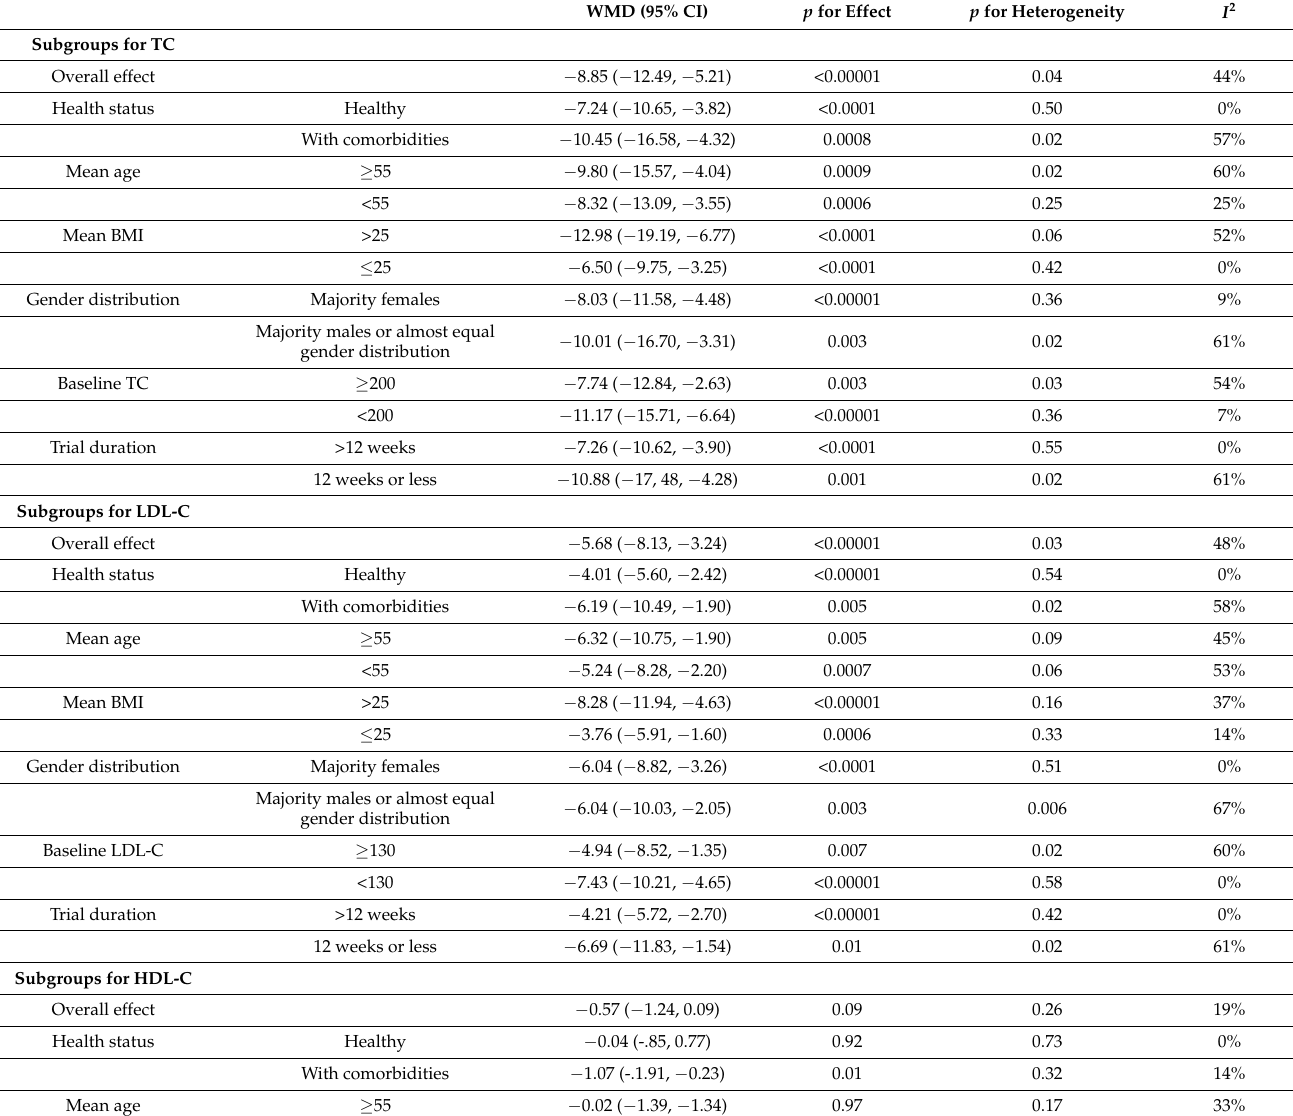
Table 2. Subgroup analyses of walnut consumption on the lipid